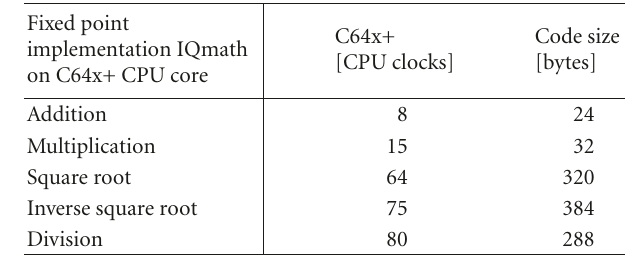
Table 4: Cycle count and code size for IQmath implementation of the key operations for numerical linear algebra (fixed point C64x+